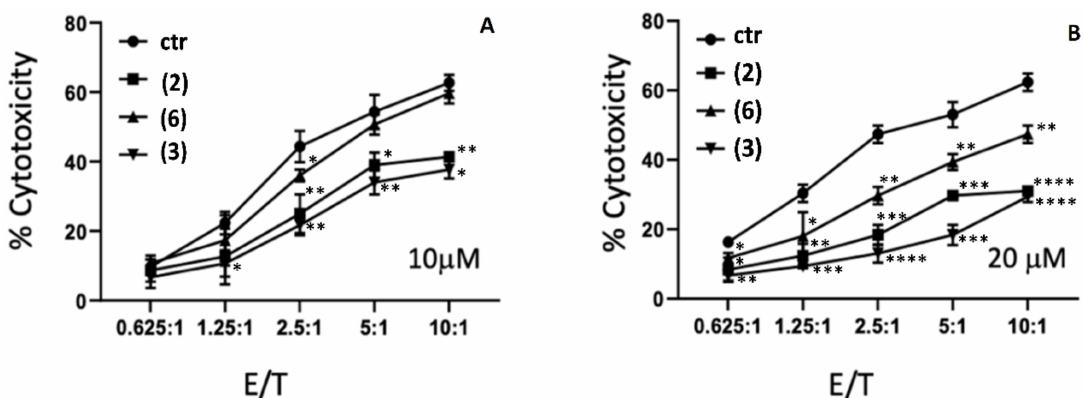
Figure 6. Natural killer NK92 cell-mediated cytotoxicity. In this study, the cytotoxic activity of NK-92 cells against K562 cells was evaluated after treatment with 10 (panel A ) and 20 µ M (panel B ) of AE ( 2 ), AE-CPP-LTV ( 6 ), and glutaryl-AE ( 3 ) at E:T ratios ranging from 10:1 to 0.625:1. CTR represent cells treated with vehicles. Data are expressed as mean ± standard deviation from 4 independent experiments. * p < 0.05, ** p < 0.01, *** p < 0.001, **** p < 0.0001 versus untreated